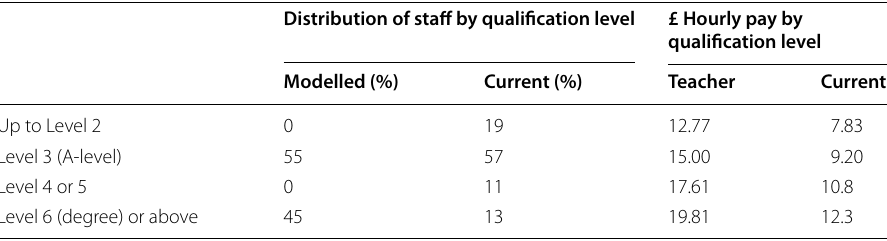
Table 2 Distribution of qualification levels and staff gross pay